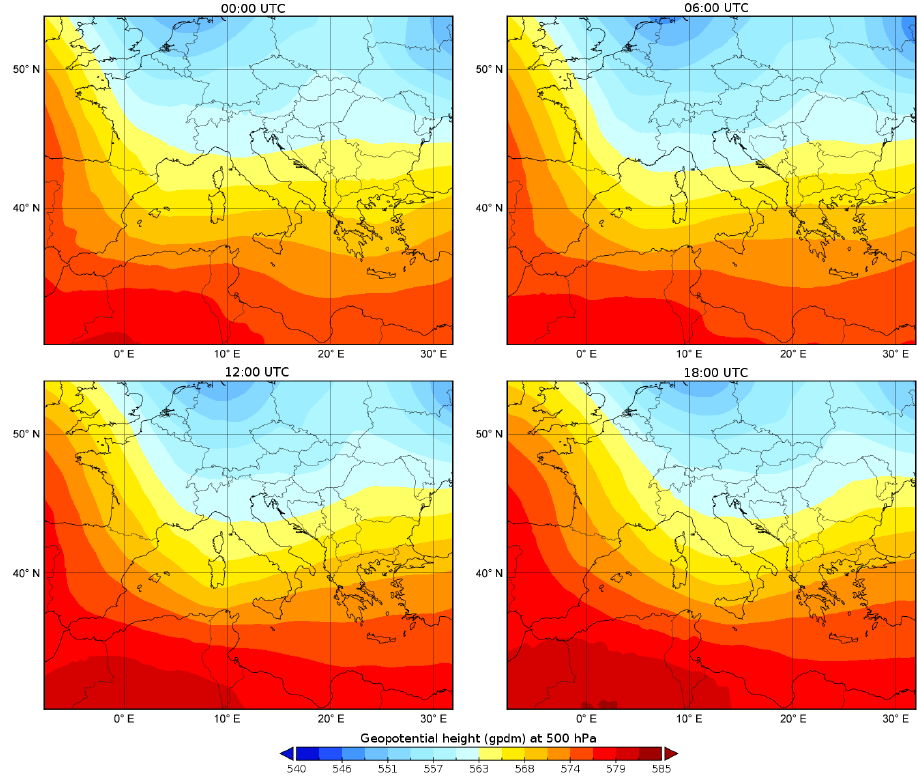
Figure 7. The 500 hPa geopotential height (gpdm) at 00:00 UTC, 06:00 UTC, 12:00 UTC and 18:00 UTC.